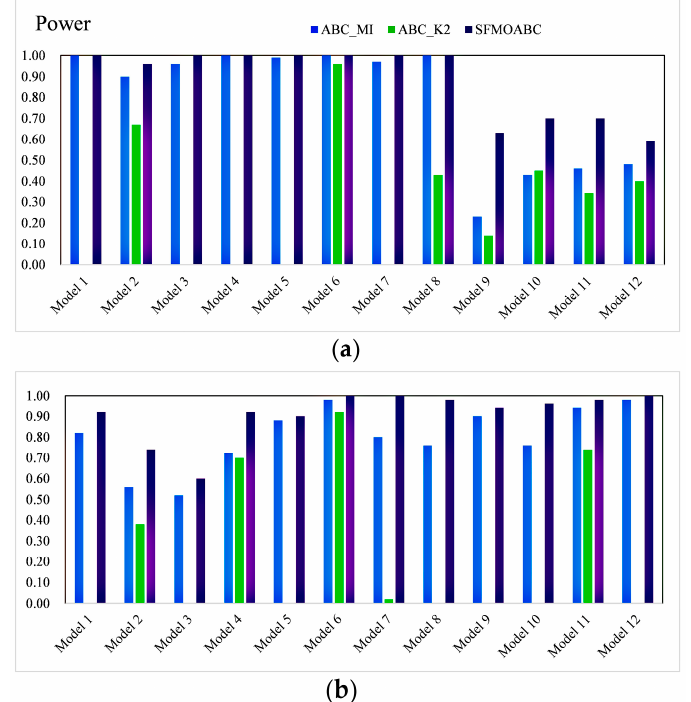
Figure 4. Power of the single-objective ABC algorithms: ( a ) Power on the small-scale datasets; ( b ) Power on the large-scale datasets.